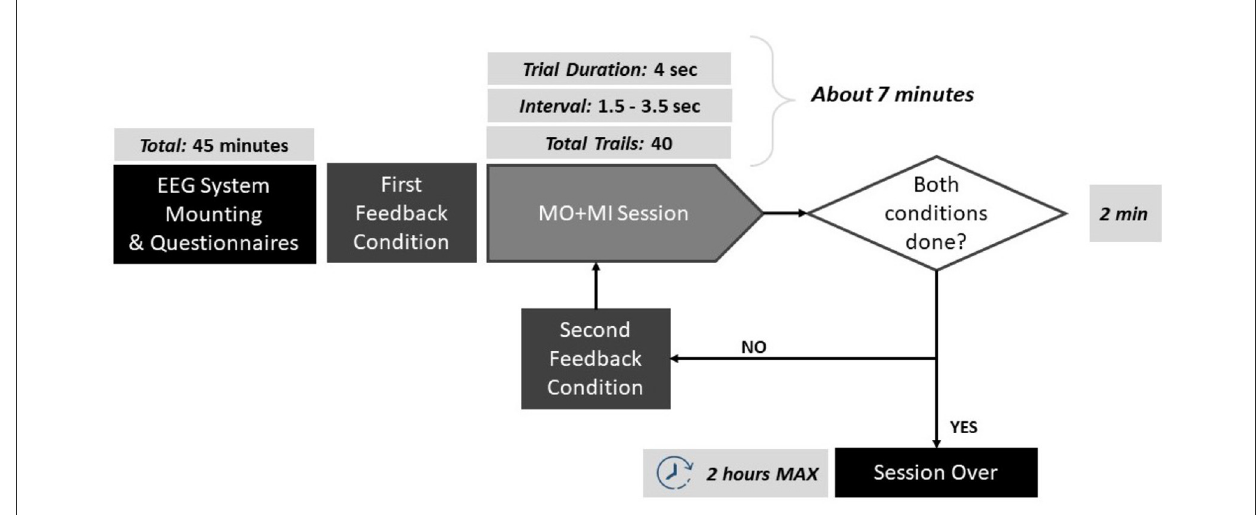
FIGURE1 Schematic of the protocol pipeline. The duration of each step is reported: the experiments lasted maximum 2 h per participant.